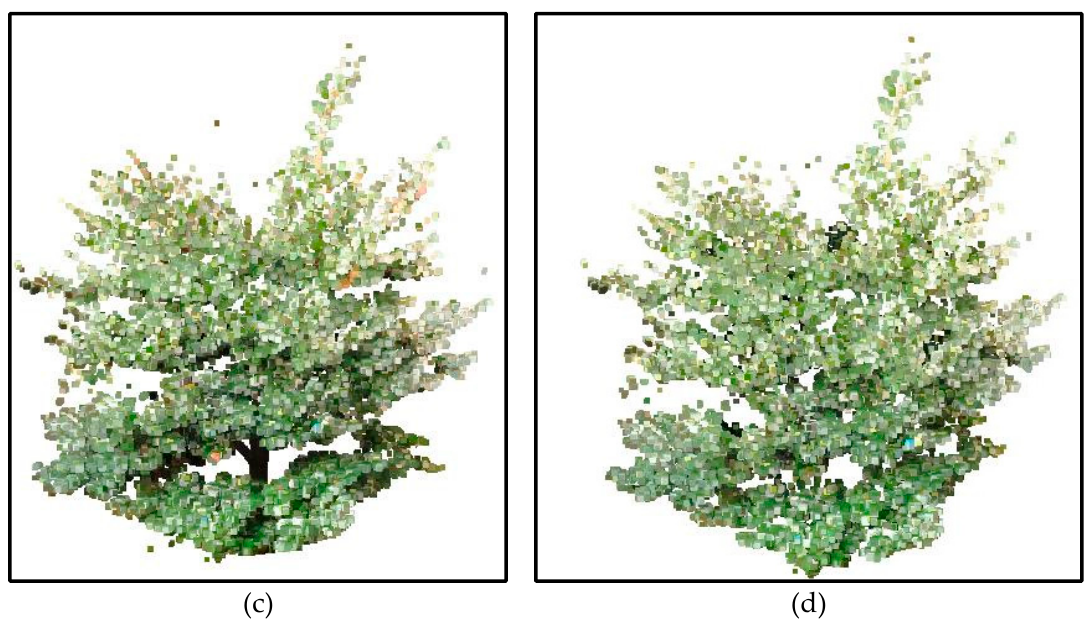
Figure 6. The classification for removing non-photosynthetic material in the case of Japanese camellia: ( a ) a* value in L*a*b* color space; ( b ) classified results (red: leaves; blue: wood); ( c ) original sampled tree; ( d ) sampled tree with wood removed.